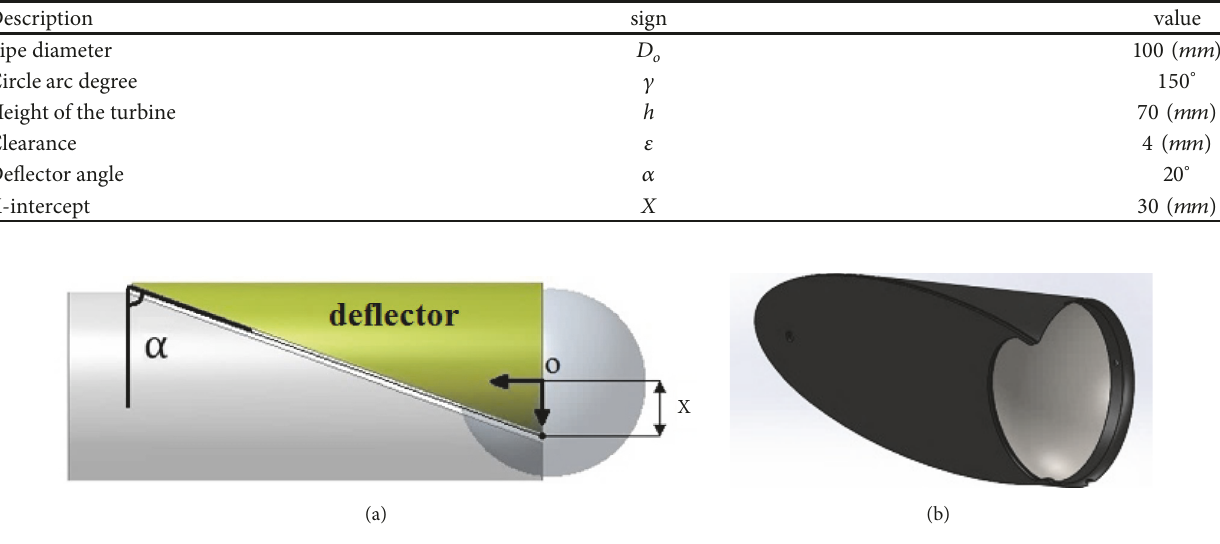
Figure 2: Schematic of constant slope deflector: (a) upper view and (b) isometric